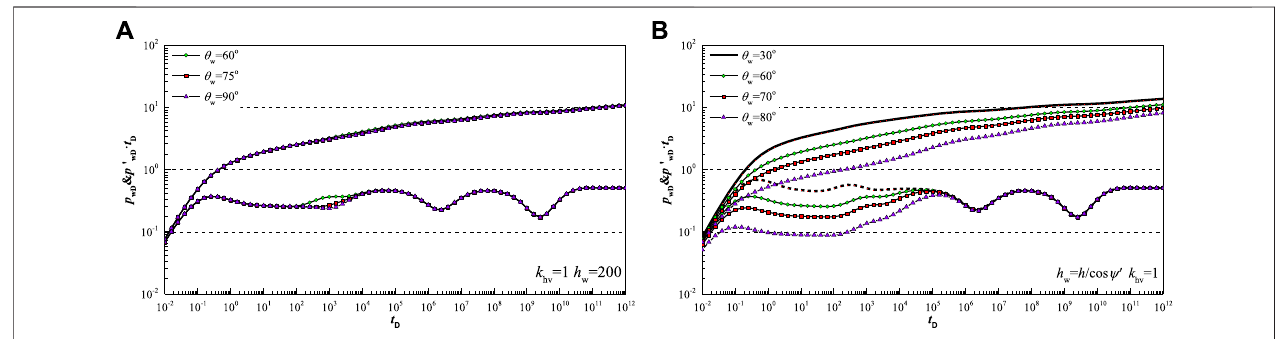
FIGURE 9 | Type curve affected by inclination angle of well ( C D (cid:2) 0 . 1 , S (cid:2) 0 . 1 , h (cid:2) 100 , h w (cid:2) h / cos ( ψ ′ ) , r w (cid:2) 0 . 1 , k hv (cid:2) 1 , k D (cid:2) 1 , κ (cid:2) 0 . 7 , ω f (cid:2) 0 . 01 , ω v (cid:2) 0 . 1 , λ (cid:2) 10 − 12 , λ (cid:2) 10 − 10 , λ (cid:2) 10 − 8 mf mV Vf